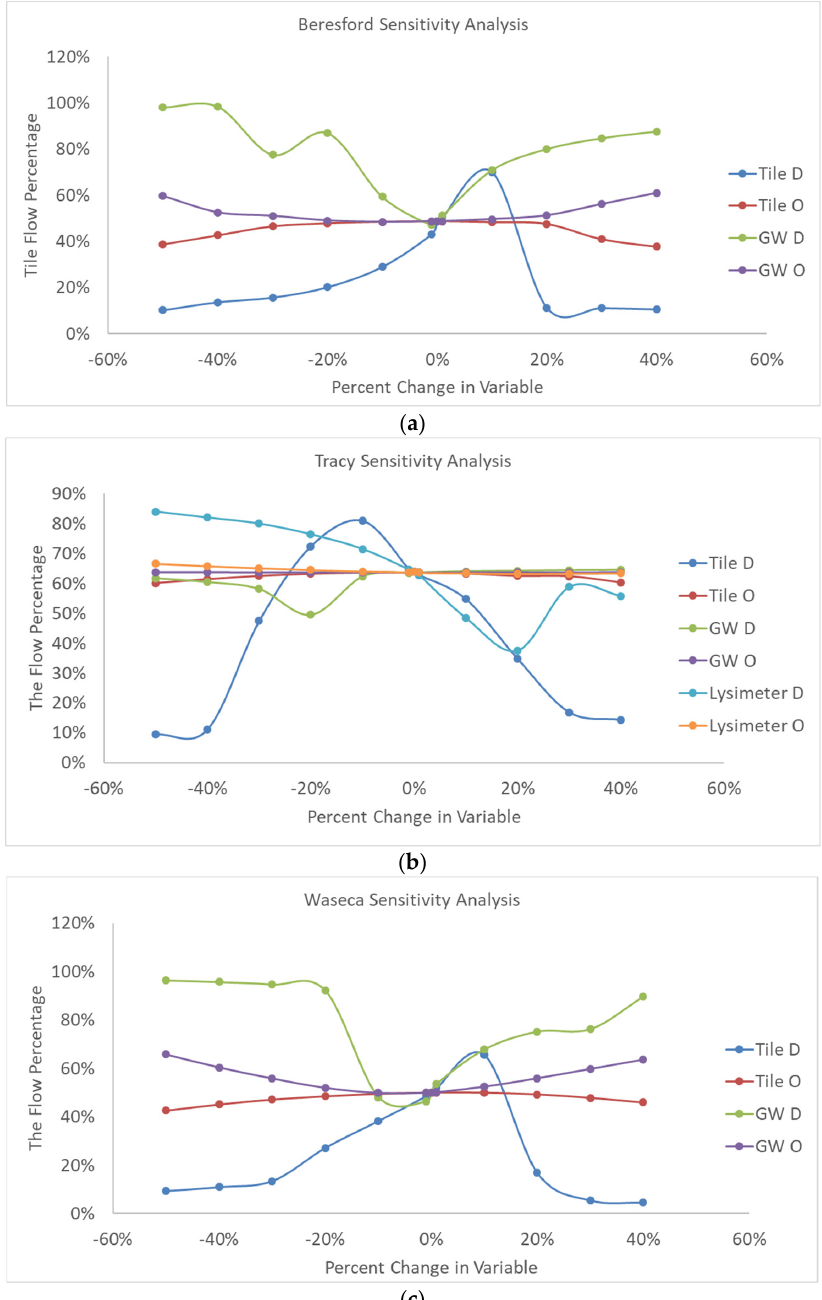
Figure 7. Sensitivity analysis where each variable was changed and the change in the estimated tile flow percentage was compared . ( a ) Waseca site; ( b ) Tracy site; ( c ) Beresford site